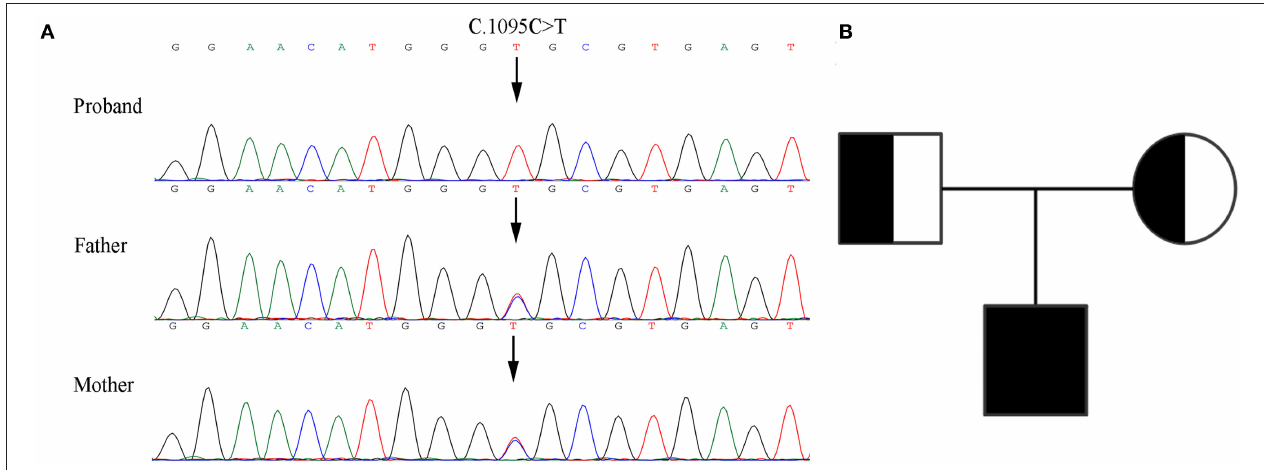
FIGURE 3 | Genetic analysis of the pedigree. (A) Sanger sequencing of the family with kEDS - PLOD1 shows that the proband is homozygous and the parents are heterozygous. (B) Pedigree chart.